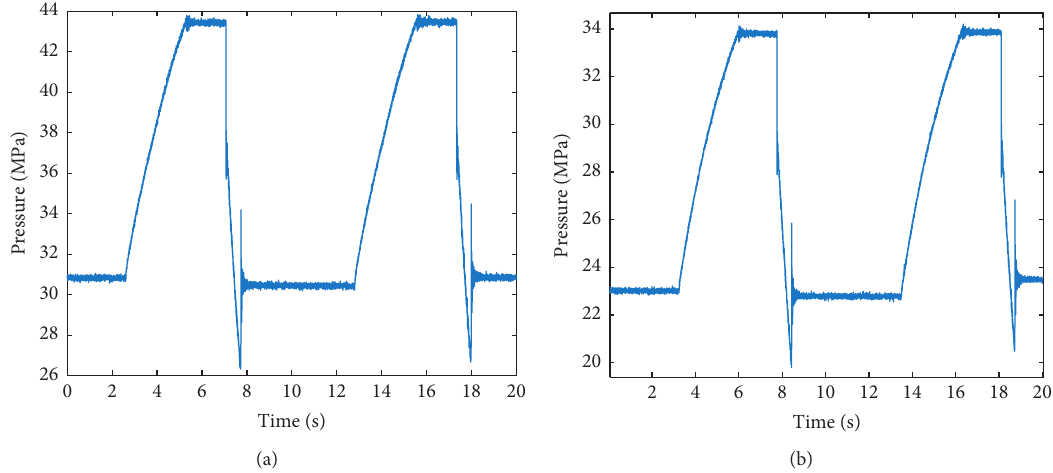
Figure 6: Hydraulic pressure waveform. (a) Top beam at the high position. (b) Top beam at the low position.